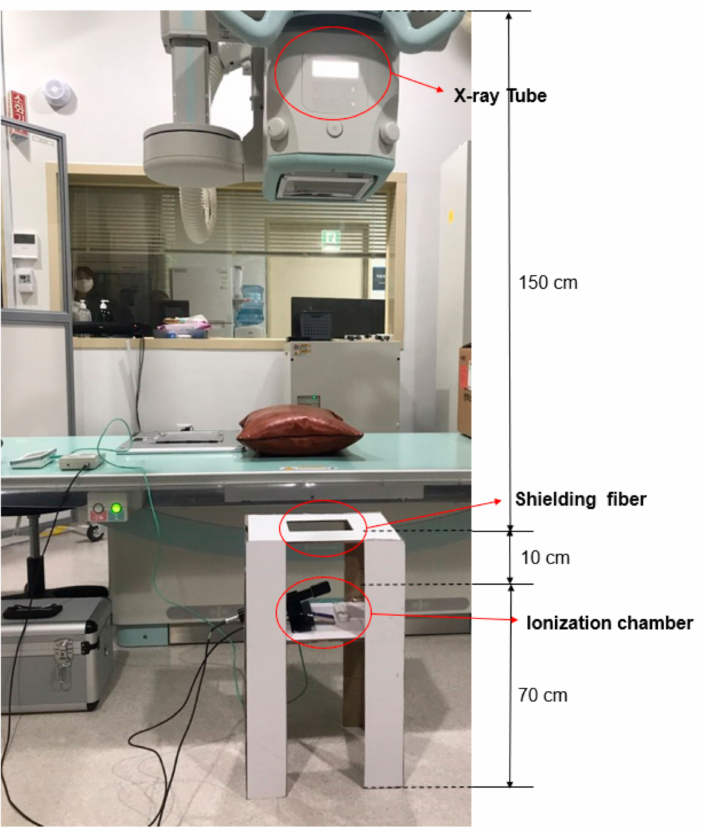
Figure 5. Method for evaluating the shielding performance of shielding